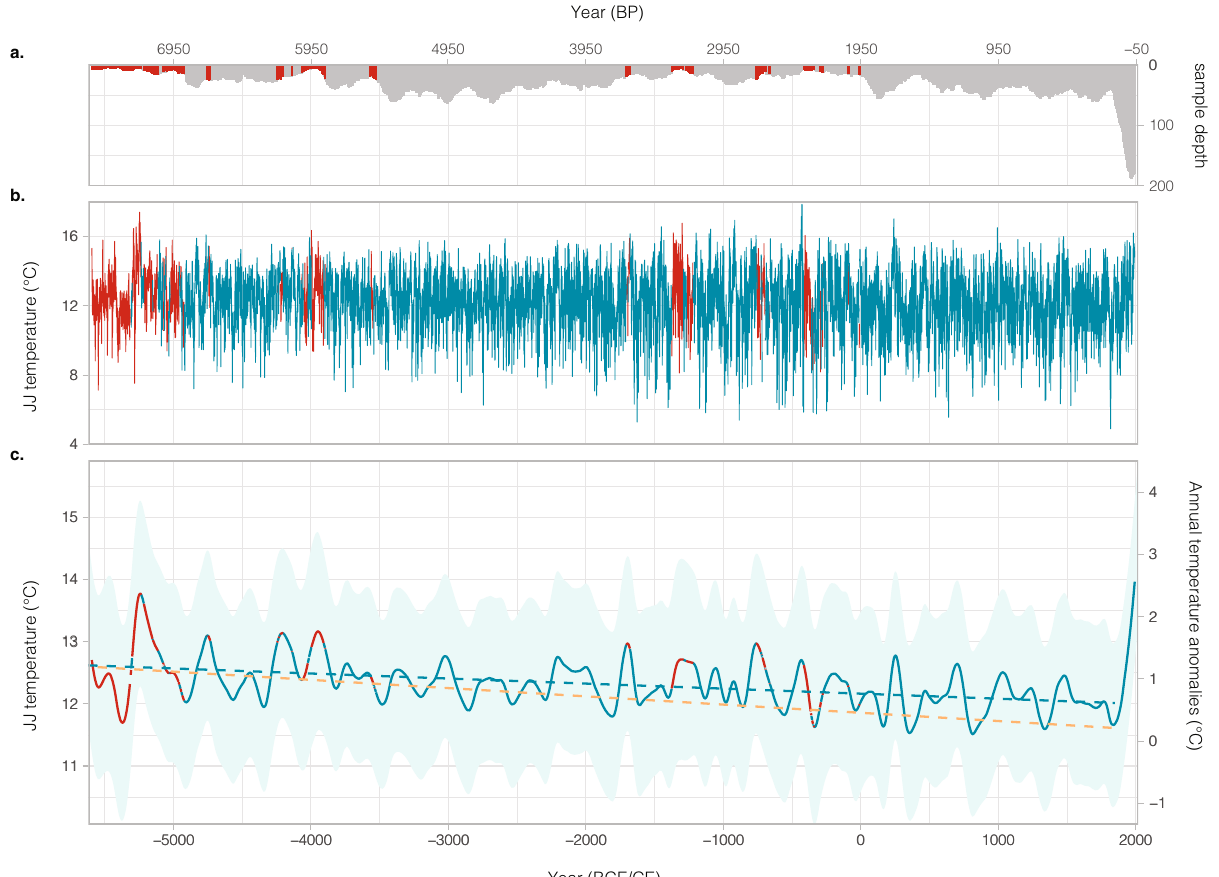
Fig. 3 | Reconstructed Yamal June – July (JJ) temperature over the past 7638 years. a Sample depth for each year over the past 7638 years. The sample depth is constantly ≥ 4 since -5618 BCE with an average of 30 samples covering each indi- vidual year (with a range from 4 to 187 samples). b Annually resolved June – July temperature reconstruction at Yamal Peninsula and c 200-year cubic spline- smoothed chronology showing a distinct Holocene cooling trend until the end of the Little Ice Age around 1850 and a sharp industrial warming over the past 170 years. The magnitude of the long-term cooling trend is insensitive to the choice of start and end years of the trend. The reconstruction uncertainty estimates (light